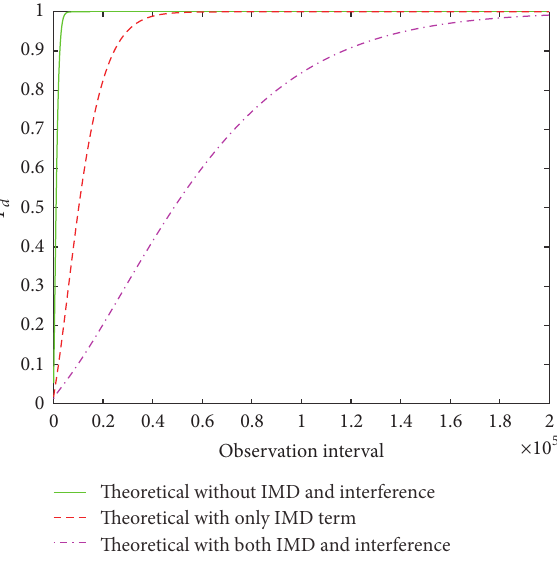
Figure 12: Observation interval versus 𝑃 𝑑 at 𝑃 fa = 0.01